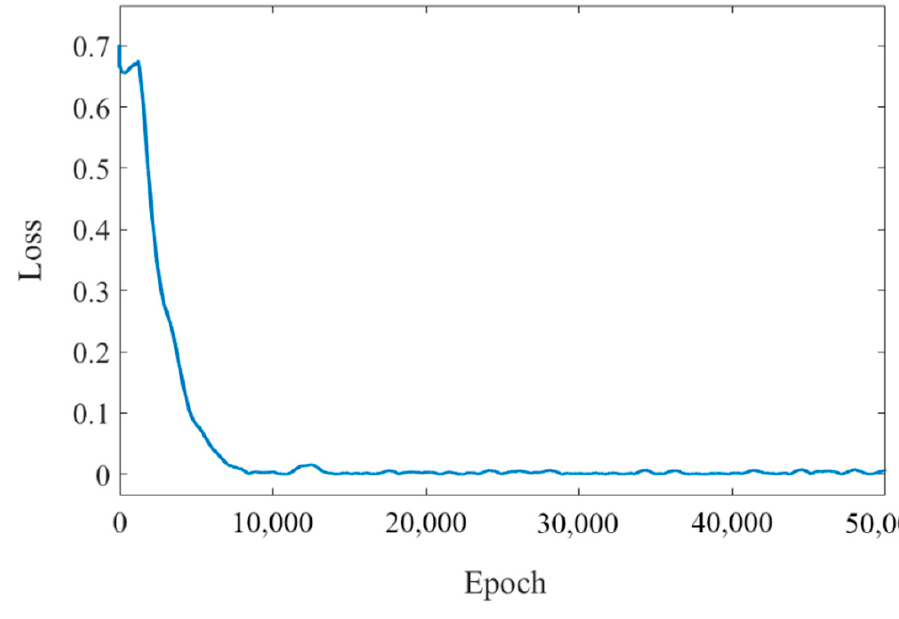
Figure 14. Training error curve of BP-PID-Smith controller under model mismatch. Table 2. Comparison of the dynamic performance of the three controllers for the model mismatch.